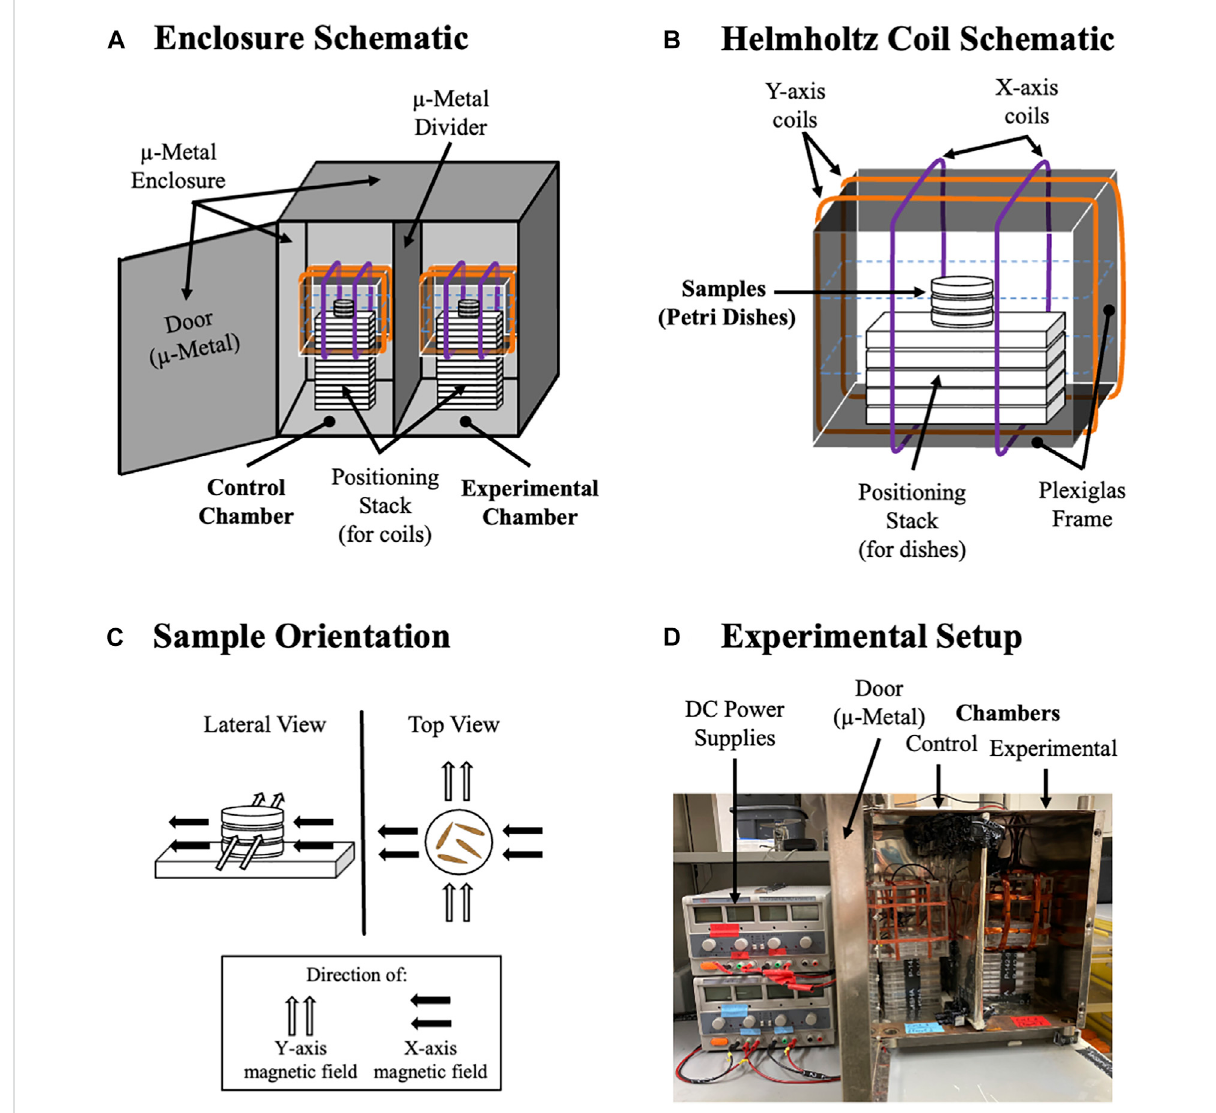
FIGURE 2 Setup for Environmentally-Controlled Magnetic Field Exposure. (A) Diagram of MagShield Box with Coils. The μ -metal enclosure has two chambers separated by a μ -metal partition. Coils are stacked on empty, 24-well culture plates (plastic) to position them in the center of